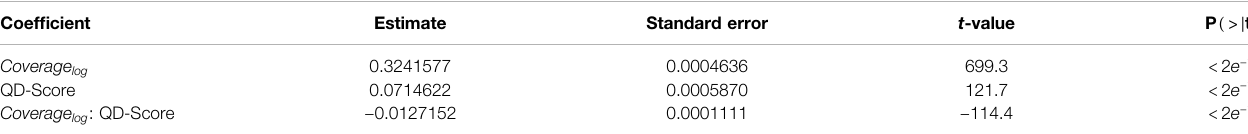
Table A4 | Coef fi cients for the model predicting fi tness based on ancestry. The model has a residual standard error of 0.5441 with 599538 degrees of